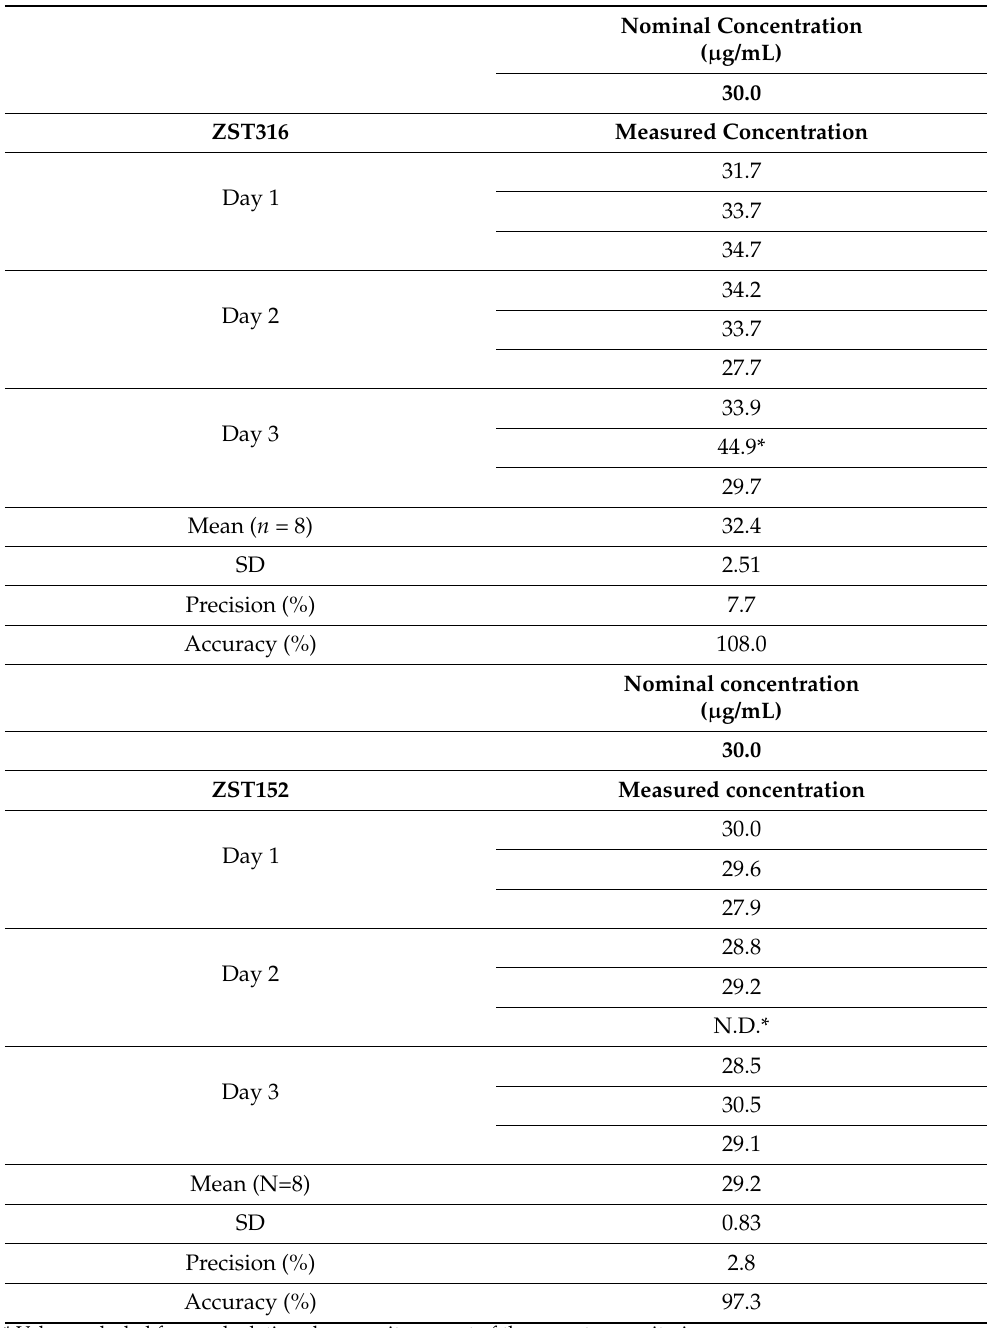
Table 5. Inter-day precision and accuracy results for ZST316 and ZST152 in